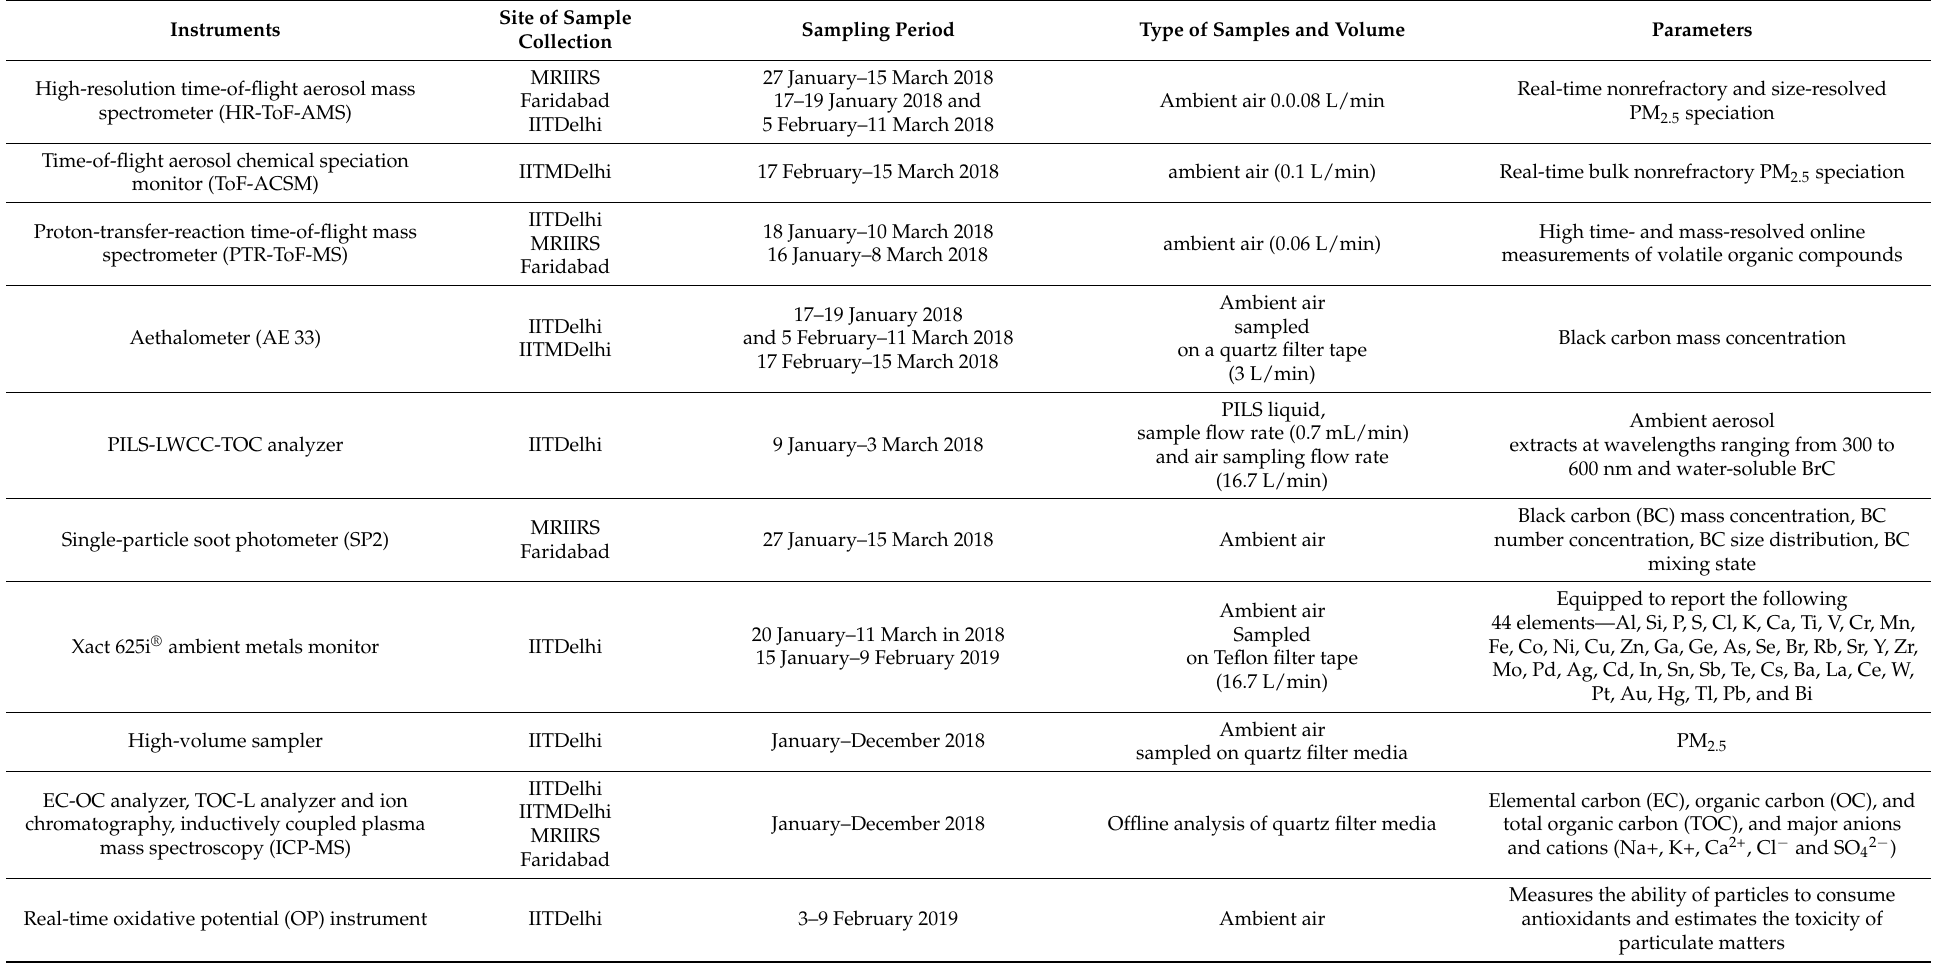
Table 1. The information on the instruments used for measuring different pollutant parameters at different sites (the details are in the main